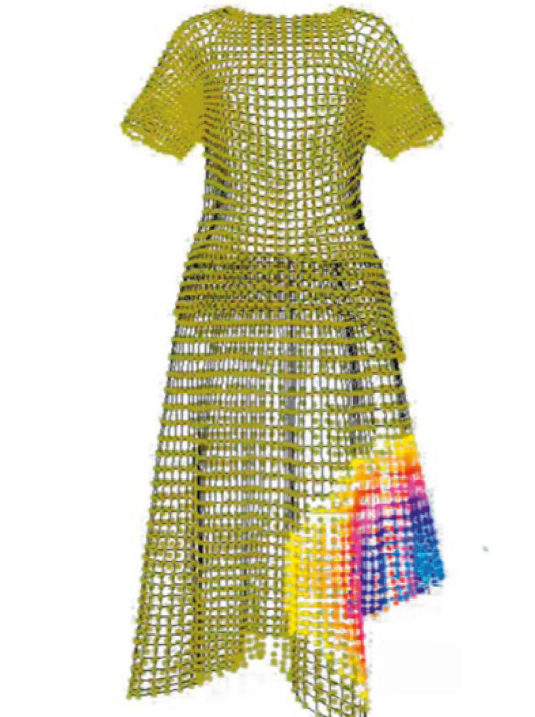
Figure 8: Schematic diagram of smart 3D clothing